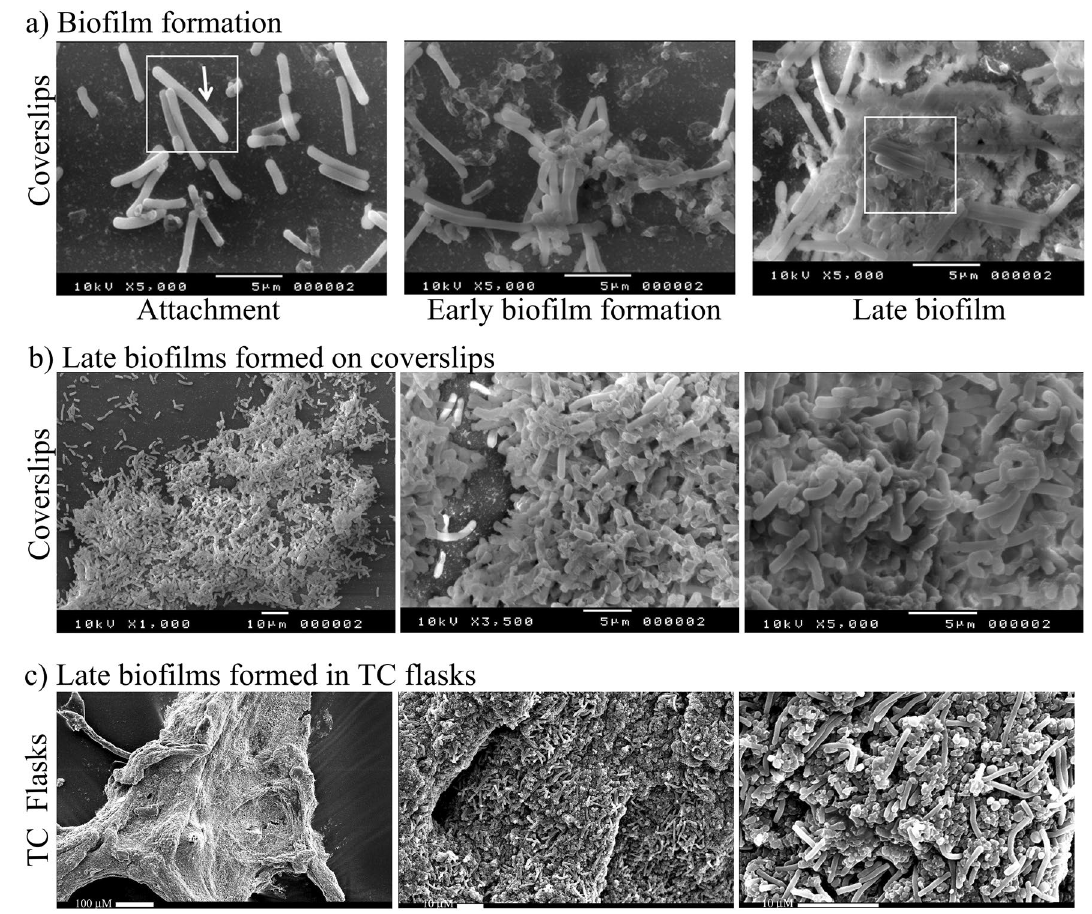
Figure 1. A schematic and SEM visualisation of biofilm formation of C. difficile strain 630. ( a ) visualization of three stages of biofilm formation grown on coverslips in 24-well plates for 16 h (attachment), 24 h (early biofilm) and 72 h (late biofilms) prior to visualization. Surface attached appendages are indicated with an arrow, within the white box. White boxes indicate high magnification images present in supplementary data (Supplementary Fig. S1 online). Scale bar 5 µm. ( b , c ) Comparison of late biofilms formed on coverslips in 24 well plates and in tissue culture flasks, fixed and transferred to a stub for imaging. ( b ) Scale bar 10 µm (×1000), 5 µm (×3500 and ×5000), ( c ) scale bar 100 µm (×150), 10 µm (×1000 and